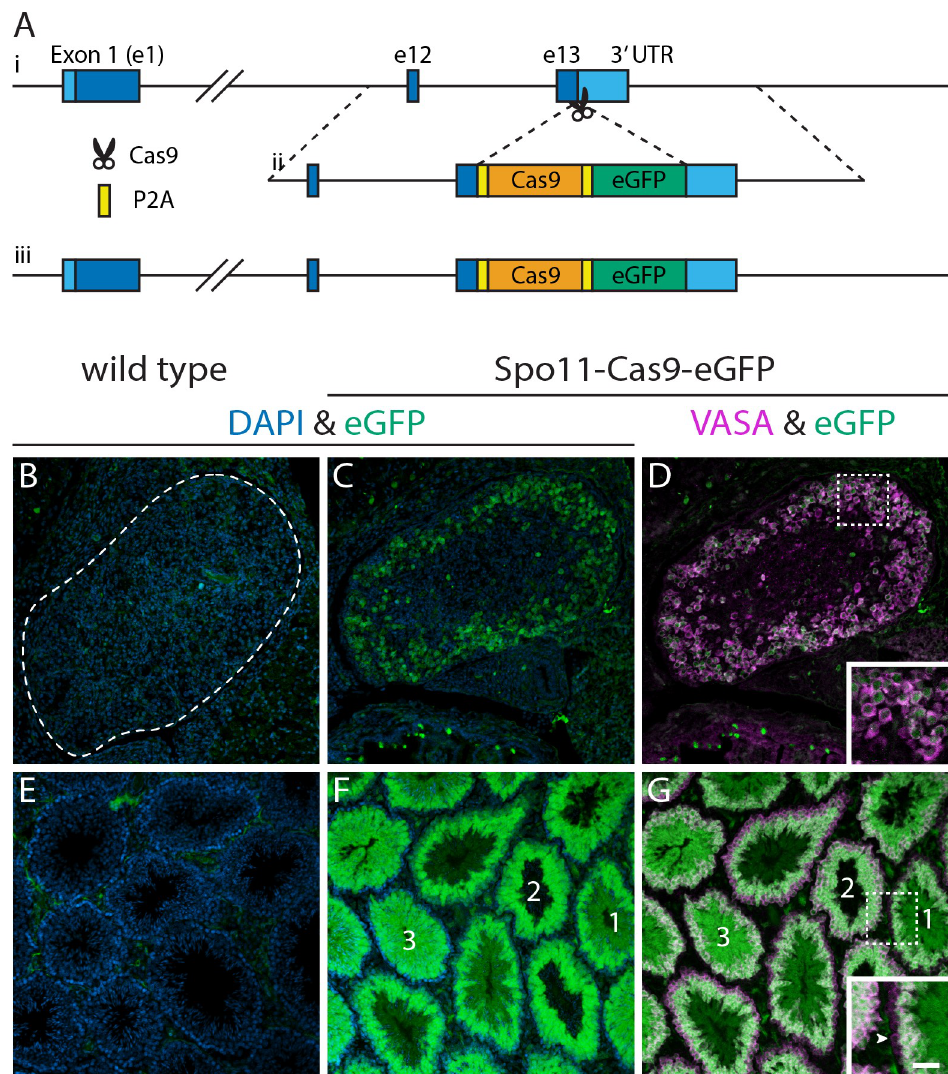
Fig 1. Male and female germ cell characterization of Spo11 Cas9-P2A-eGFP knock-in expression. (A) Schematic of targeting the Spo11 Cas9-P2A-eGFP knock-in allele. (i) Wild-type Spo11 locus. (ii) Construct for insertion. (iii) Final Spo11 Cas9-P2A-eGFP knock-in locus. The genotyping strategy is depicted in S7 Fig. (B–G) Immunofluorescent detection of eGFP (green) and VASA (magenta) plus DAPI (blue) in Spo11 +/+ (B, E) and Spo11 Cas9-P2A-eGFP/+ (C,D; F,G) mice. (B–D) embryonic ovaries at E18.5 ( n = 3) and (E–G) adult testes ( n = 3). Seminiferous tubules labeled 1 - > 3 are in different stages of maturation as determined by chromatin compaction (DAPI) and relative level of VASA expression in outer perimeter cells. The inset shows outer perimeter cells of tubule 1 (arrowhead points to spermatogonium) that express low VASA and no eGFP. By contrast, the outer perimeter cells of tubule 2 (meiotic primary spermatocytes) express higher VASA and low eGFP, and outer perimeter cells of tubule 3 express the highest eGFP. Scale bar: 50 μ m for (B–G) and 25 μ m for the insets in (D) and (G). eGFP channel brightness was adjusted in (B–D) independent of (E– G); equivalent exposures and all biological replicates are shown in S4